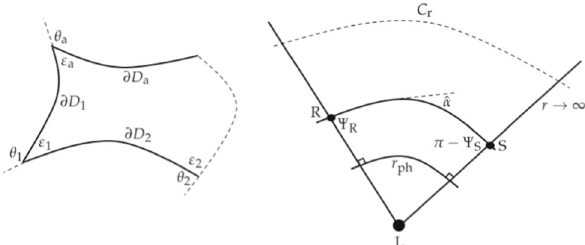
Fig. 1 In the left is the schematic picture of a curved surface for Gauss–Bonnet theorem. In the right, the upper quadrilateral describes the domain for GBT as found by Ishihara et al. [36], while the middle quadrilateral was used in Ref. [41] for non-asymptotic